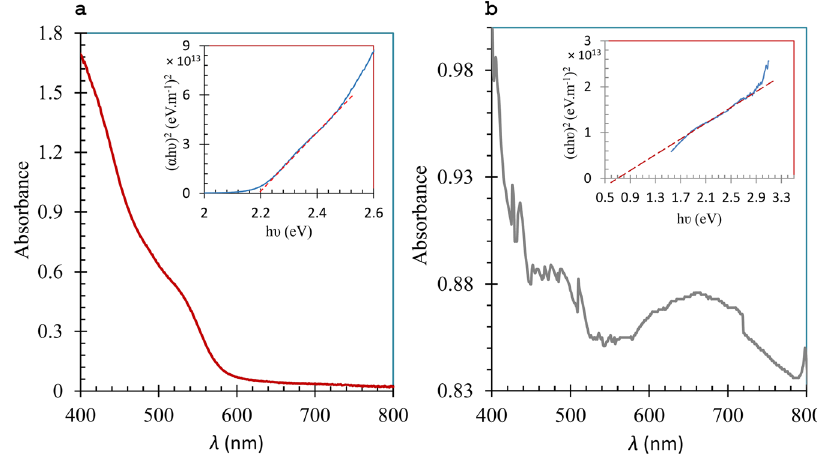
Fig. 2 Absorption and Tauc plots. The diagrams are depicted for hematite ( a ) and pyrite ( b ) thin fi